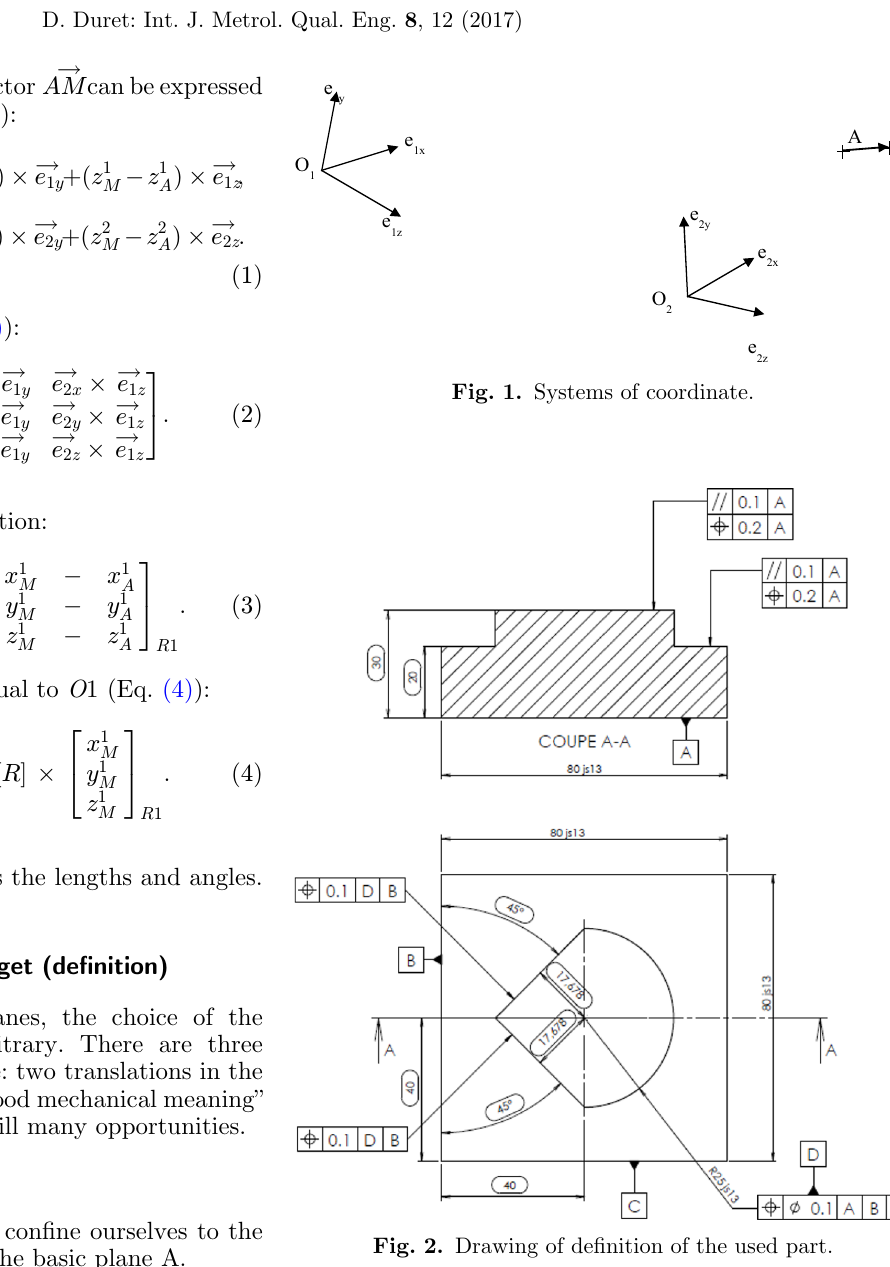
Fig. 2. Drawing of de fi nition of the used part.